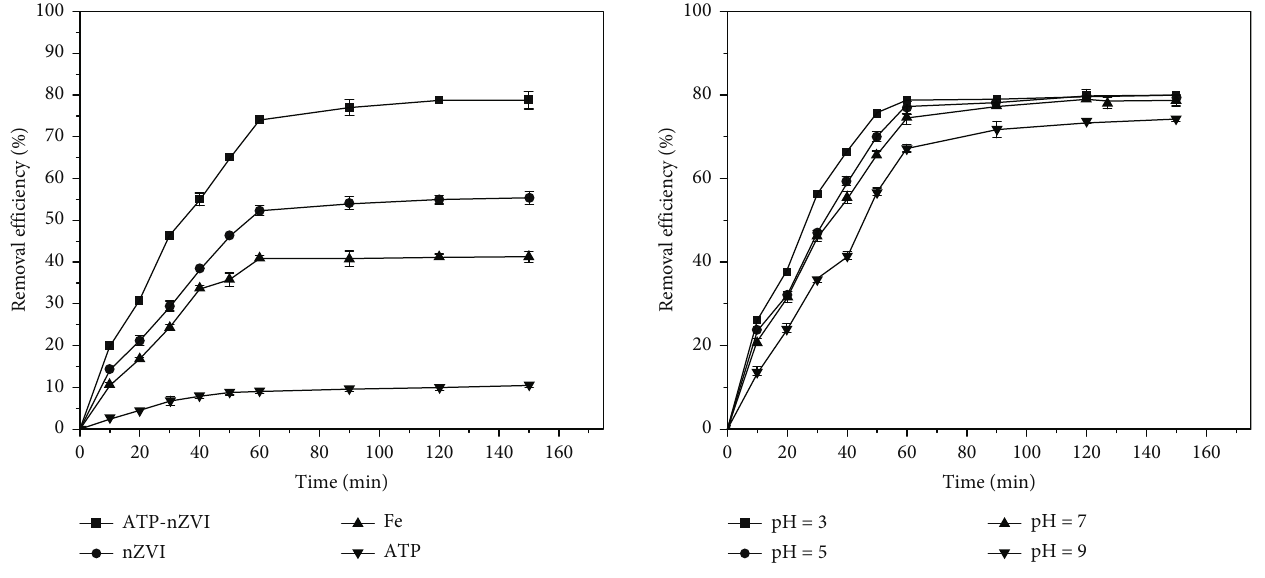
-N removal rate 3